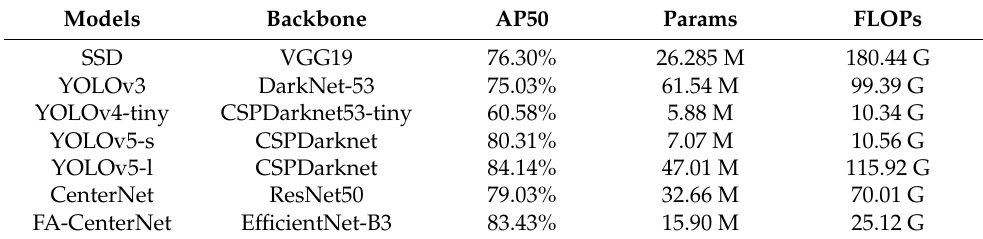
Table 5. Quantitative results of different detection methods in CURPC 2020 datasets. Models